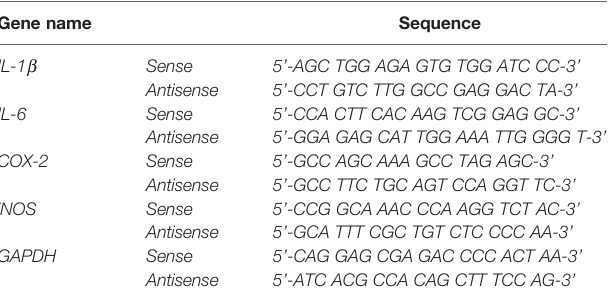
TABLE 1 | Sequences of primers used for RT-PCR.